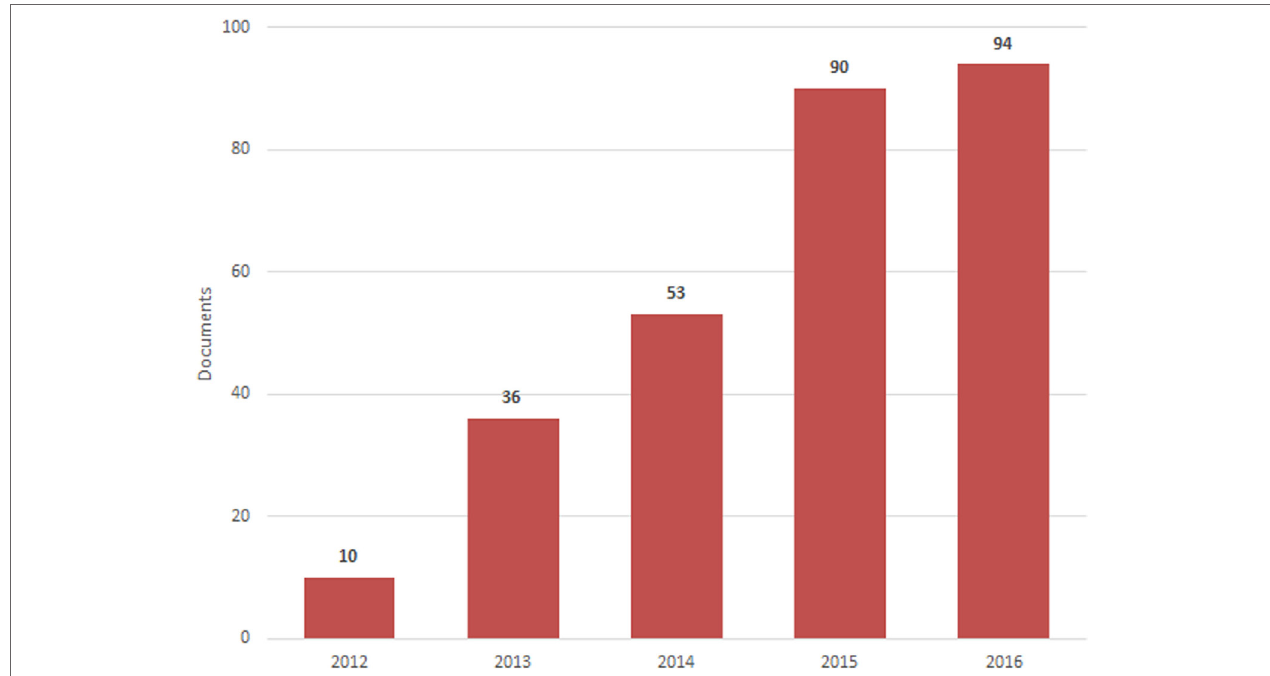
FigUre 1 | Evolution of the number of articles on Altmetrics